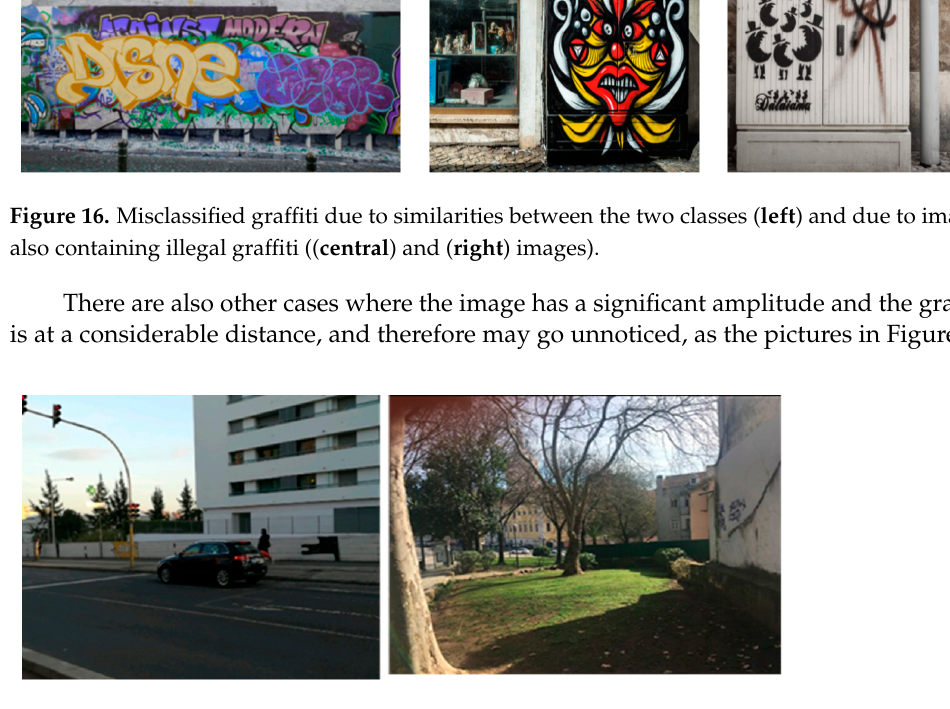
Figure 17. Examples of pictures where the graffiti is at a large